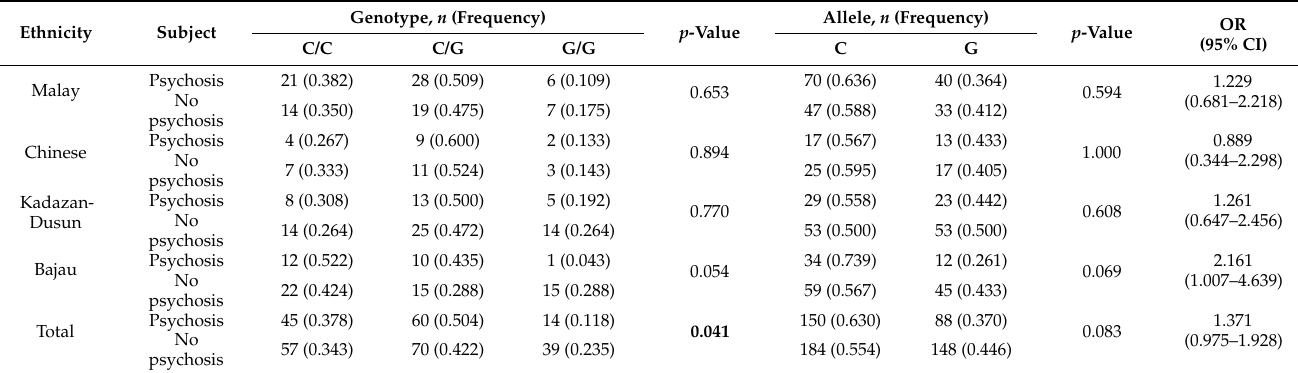
Table 3. Genotype and allele frequencies of the SLC1A2 rs4755404 polymorphism in male METH- dependent subjects with and without psychosis.